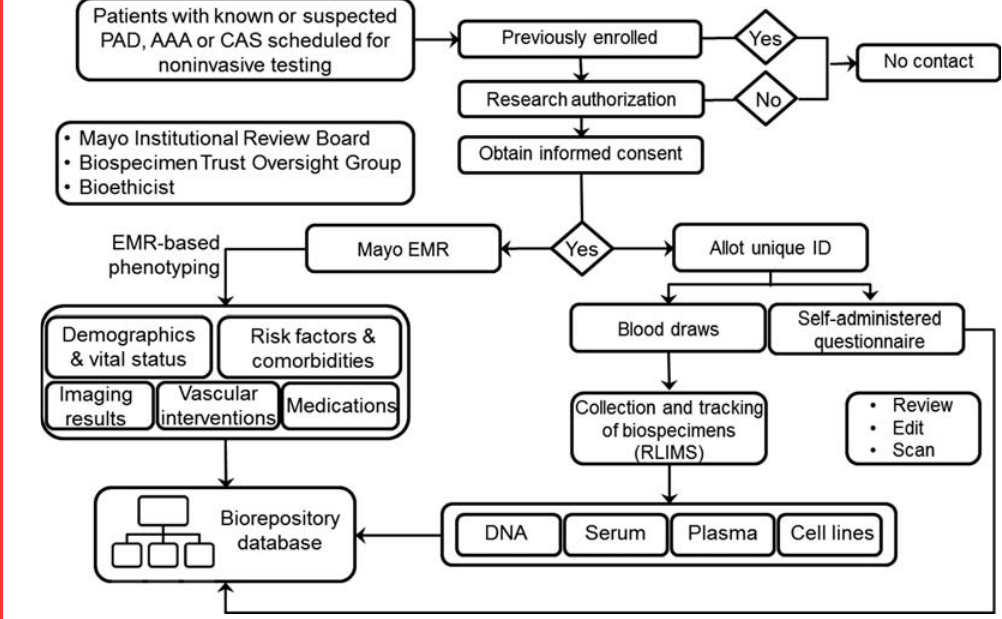
Figure 2. Overview of the Vascular Disease Biorepository. RLIMS ¼ research laboratory information management systems; CAS ¼ carotid artery stenosis; AAA ¼ abdominal aortic aneurysm; PAD ¼ peripheral arterial